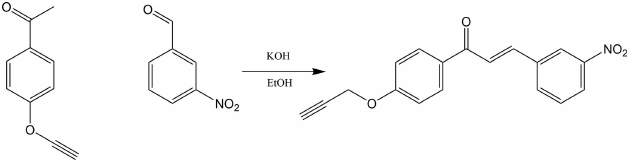
Figure 2 Packing diagram for the title compound showing the C–H (cid:3)(cid:3)(cid:3) O inter- actions linking the molecules into sheets in the (211) plane.